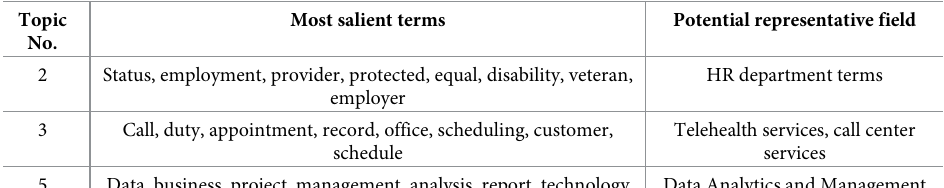
Table 2. US data top three topics (Period 1). Topic No.